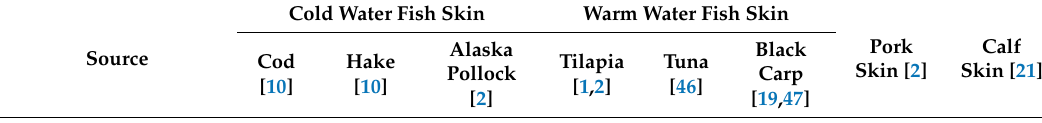
Table 1. Amino-acid composition of some fish gelatins compared to pork and calfskin